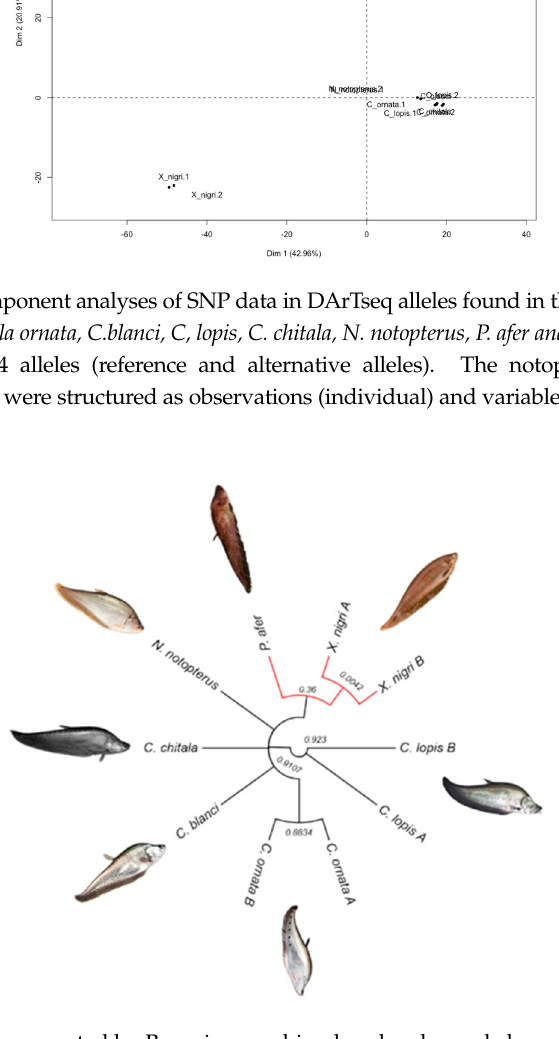
Figure 10. Dendogram generated by Bayesian combined molecular and chromosomal data from the notopterid family. Red branches represent species from Africa. Numbers in the nodes represents the Bayesian posterior probabilities.